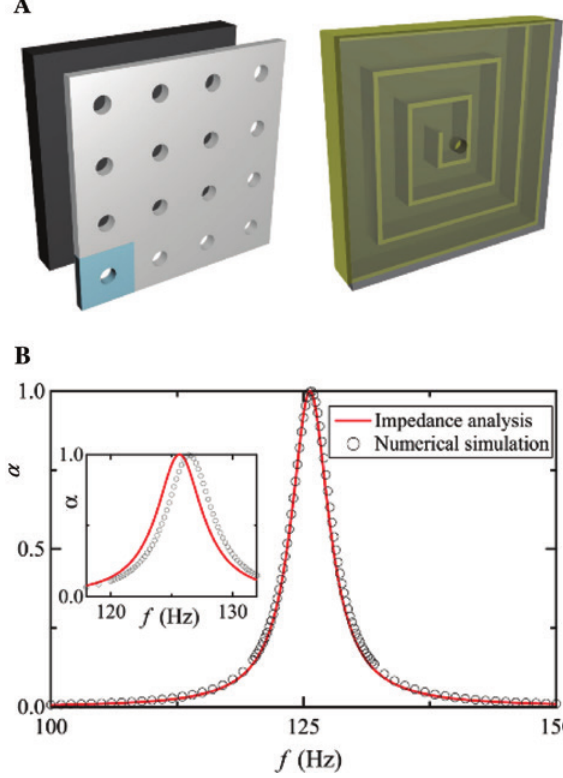
Figure 13: Metasurface-based